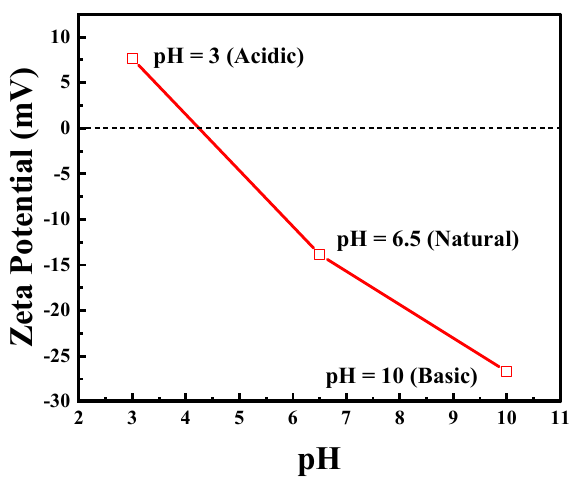
Figure 4. Zeta potential at different pH of the synthesized exfoliated g-C 3 N 4 . Reproduced with permission from [18].